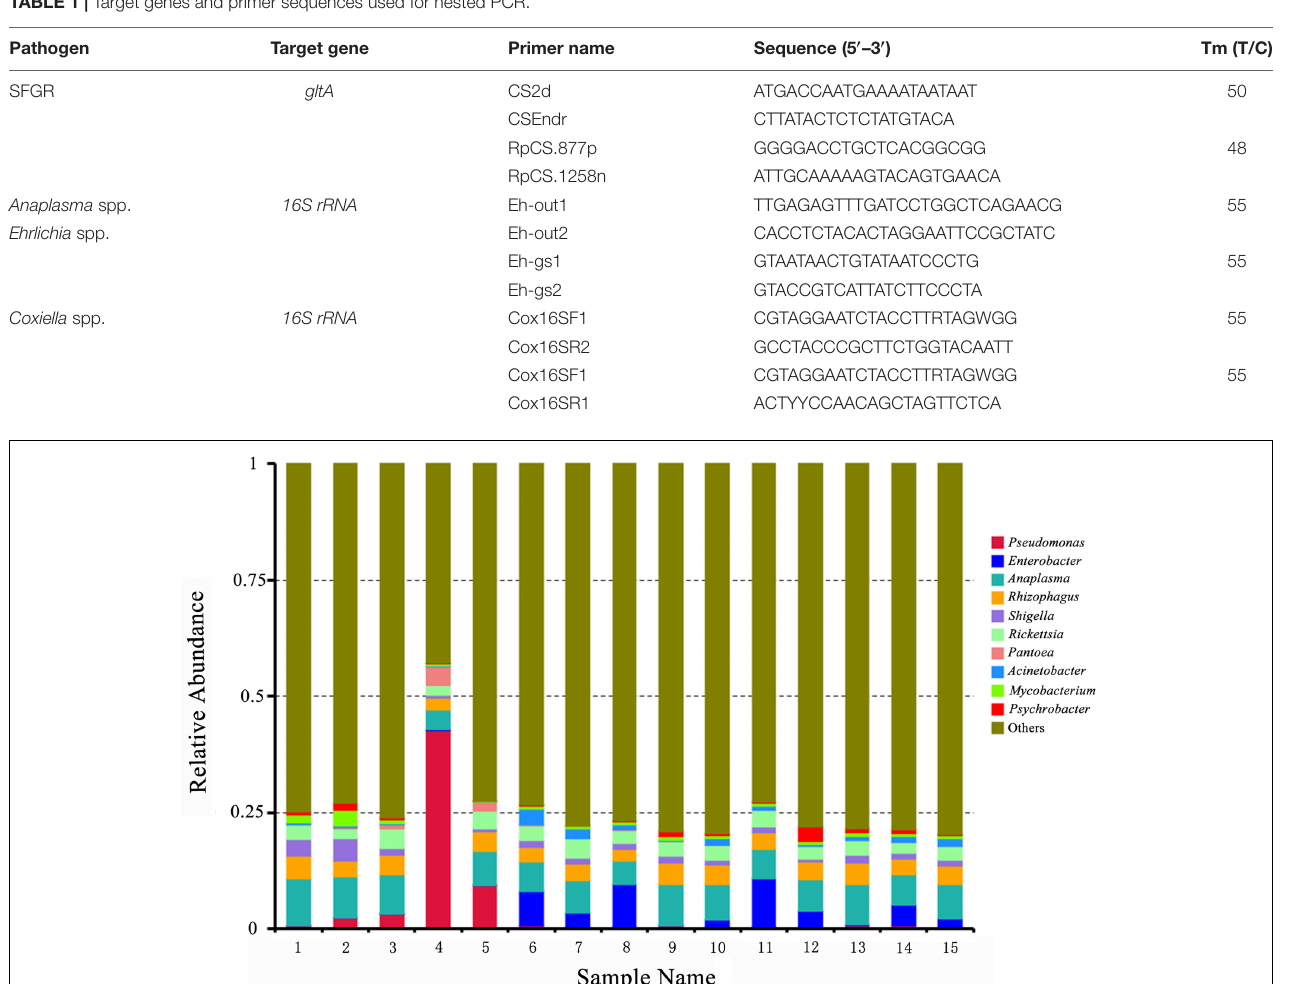
TABLE 1 | Target genes and primer sequences used for nested PCR.